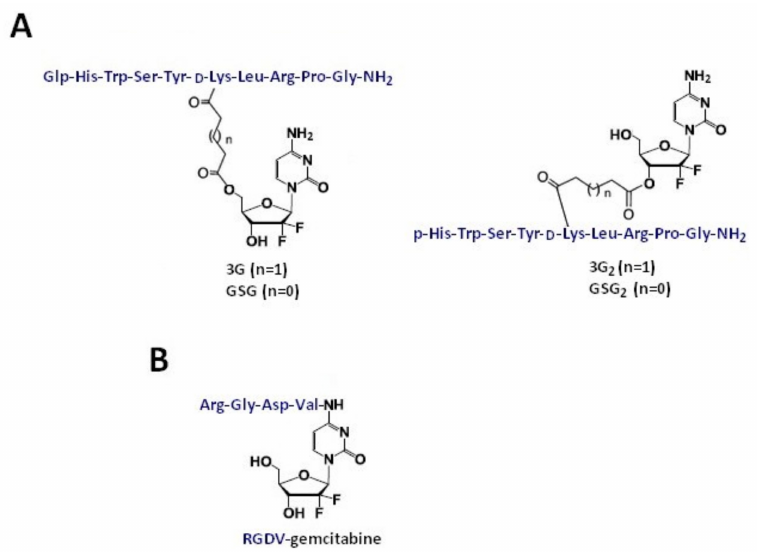
Figure 3. Chemical structures of gemcitabine conjugates with receptor-binding peptides. ( A ) Conjugates of gemcitabine with GnRH-R ligand peptide and ( B ) conjugate of gemcitabine with RGDV peptide. Gemcitabine-Succinate-GnRH Conjugates with Improved Metabolic Properties and Dual Mode of